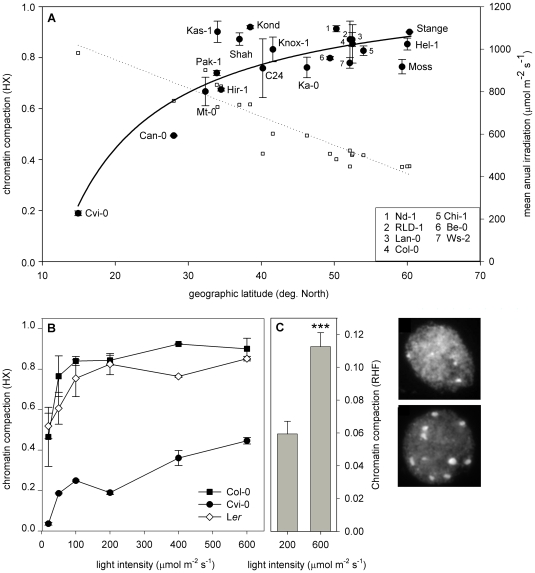
Chromatin compaction correlates with latitude of origin and light intensity levels.(A) Chromatin compaction correlates with latitude of origin. Left Y-axis represents chromatin compaction (HX) of plants grown at a light intensity of 200 µmol m−2 s−1 in short-day photoperiod (closed round symbols), and right Y-axis represents mean annual irradiation (open squares), on the geographic latitude of collection sites. The best-fitted curves are shown (HX; closed line, mean annual irradiation; dotted line). Inset shows abbreviations of the clustered accessions depicted above in the graph. n≥2. (B) Chromatin compaction of Col-0 (black squares), Ler (white diamonds), and Cvi-0 plants (black circles), grown in different light intensities. n≥2. (C) Relative Heterochromatin Fraction (RHF) of Cvi-0 grown in different light intensities in short-day conditions. n≥30, *** p<0.001 significance value compared to standard conditions (200 µmol m−2 s−1). Error bars represent SE in al cases. Images show nuclei of Cvi-0 plants grown at 200 µmol m−2 s−1 (left) and 600 µmol m−2 s−1 (right).